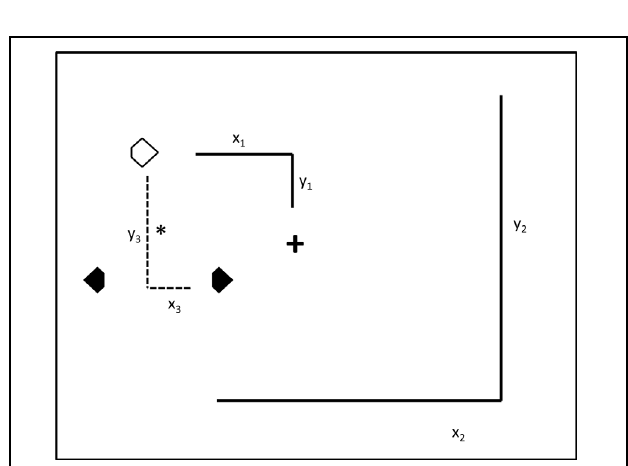
appear. An invariant sequence contained eight trials and was repeatedly shown 126 times per session. In Experiment 2, the fixation cross and the search items were randomly displaced between the top, center, and bottom region across trials.